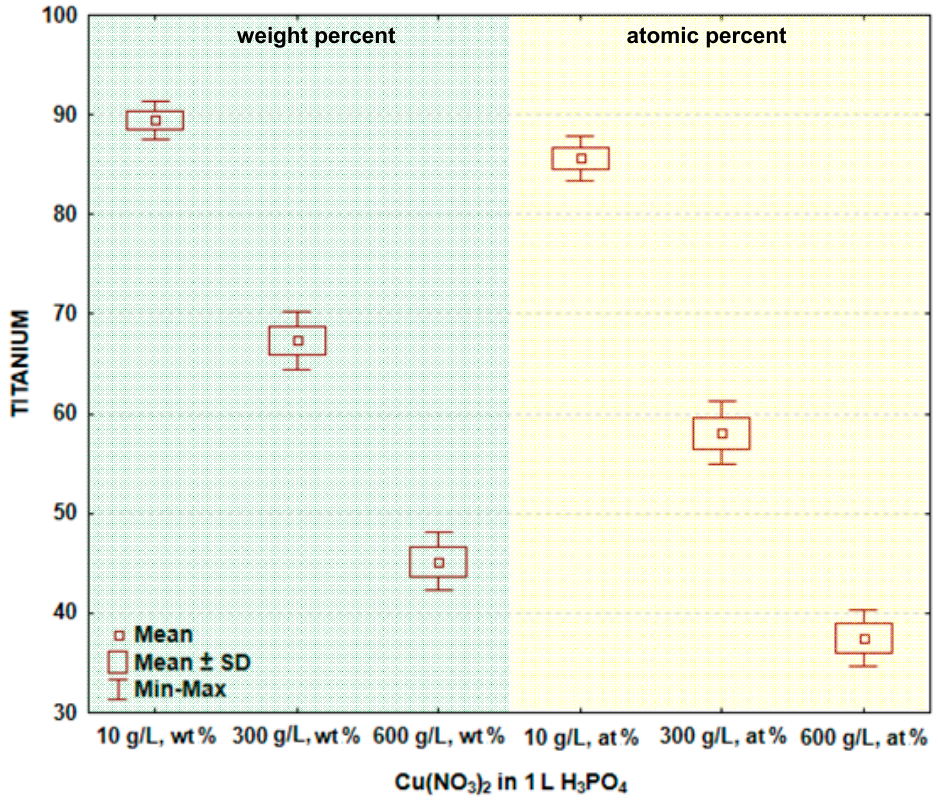
Figure 4. Box and whisker plots of the amount of titanium in the surface layer formed on titanium after PEO.